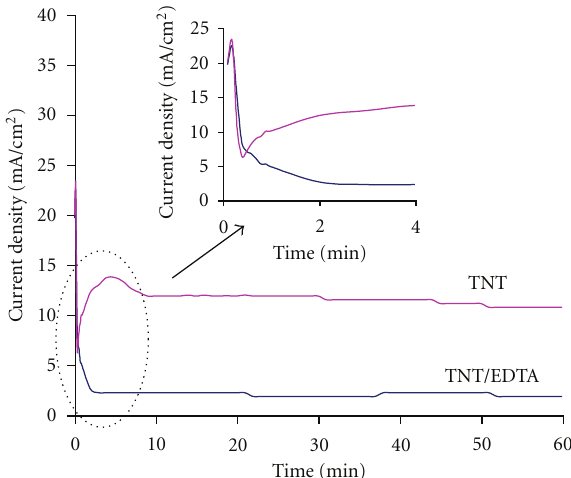
Figure 6: Current density transient recorded during anodization with and without the presence of complexing agent. Inset is the magnifying view of the initial anodization